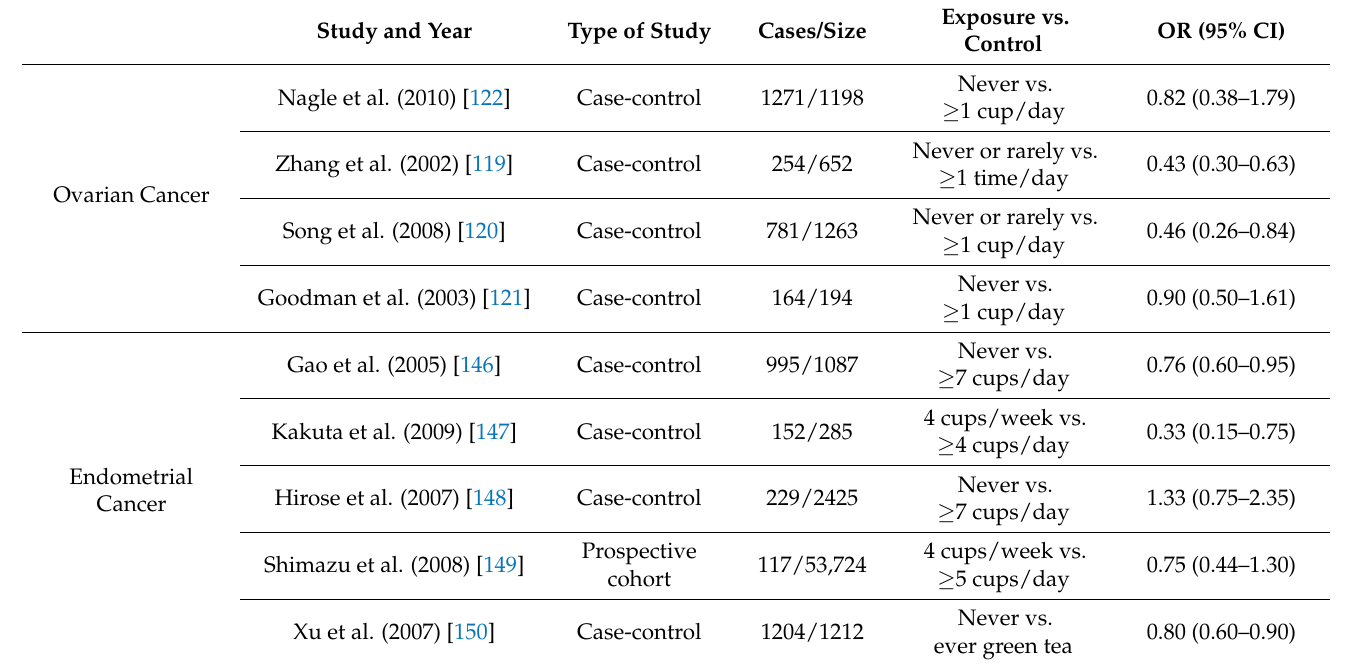
Table 3. Observational studies examining the effect of dietary intake of green tea on reproductive